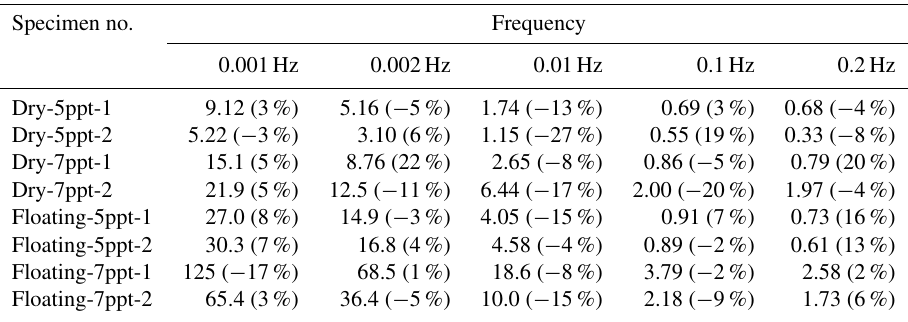
Table 5. Modeling results of the strain energy density (Jm − 3 ) dissipated per loading–unloading cycle (the values given in parentheses are error percentages of model predictions relative to experimental results).